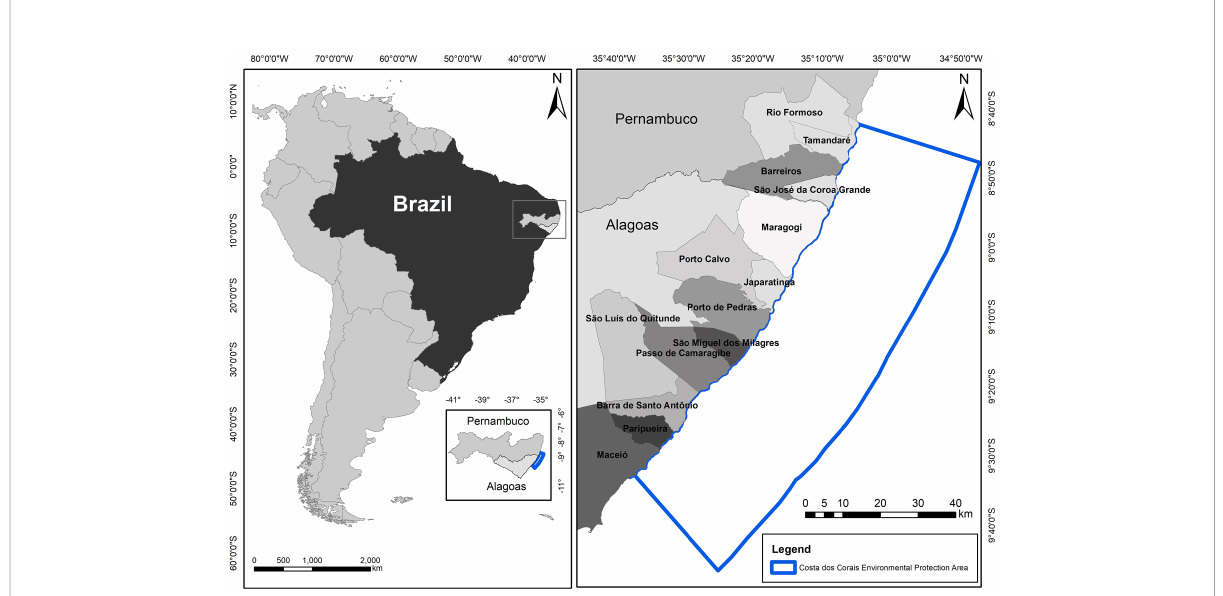
FIGURE 1 Map of the study area with representation of the municipalities that make up the Costa dos Corais Environmental Protection Area (Contribution by Roma ́ rio Oliveira de